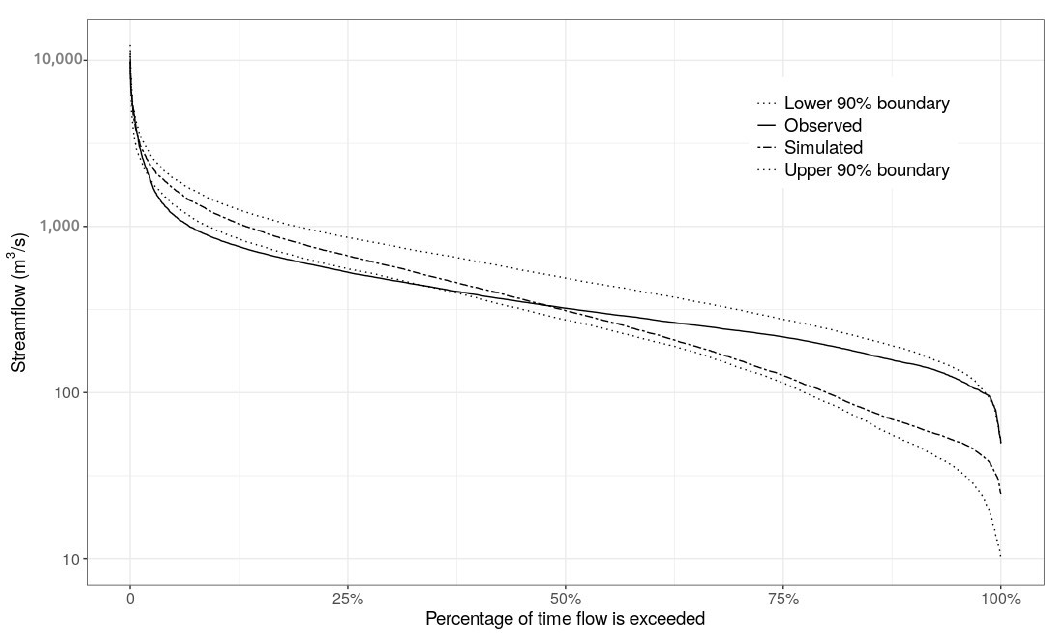
Figure 2. Flow Duration Curve plot of the 32 years observed data, simulation result of the highest rank parameter, and the GLUE uncertainty